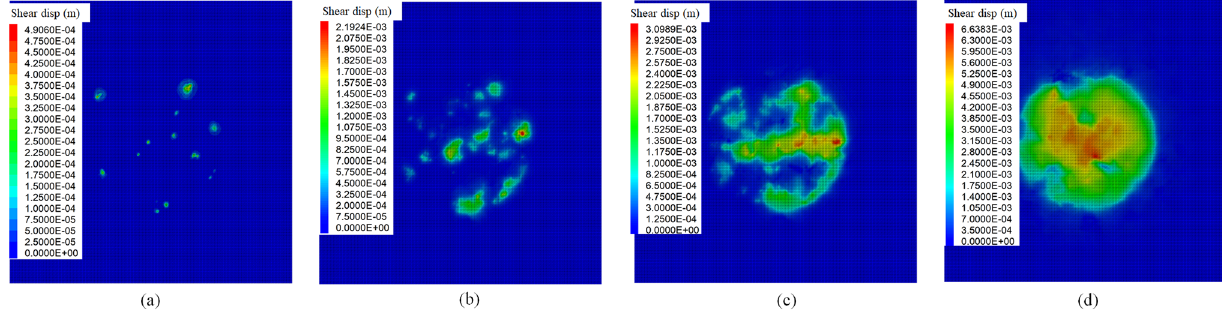
Fig. 8 Shear displacement increment on the fault plane during each stage (not cumulative): a 10th stage b 15th stage c 20th stage d 25th